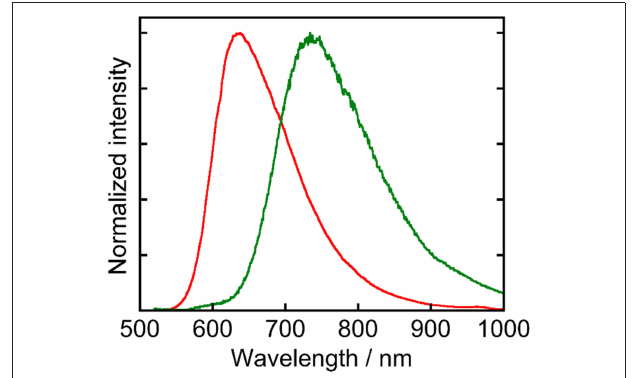
FIGURE 3 | Cyclic voltammograms of Ru(pic) and Ru(dmb) measured in a DMA solution containing Et 4 NBF 4 (0.1M) as a supporting electrolyte with a Ag/AgNO 3 (10mM) reference electrode.